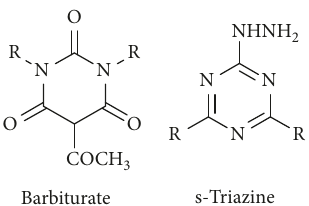
Figure 1: General structure of barbiturate and